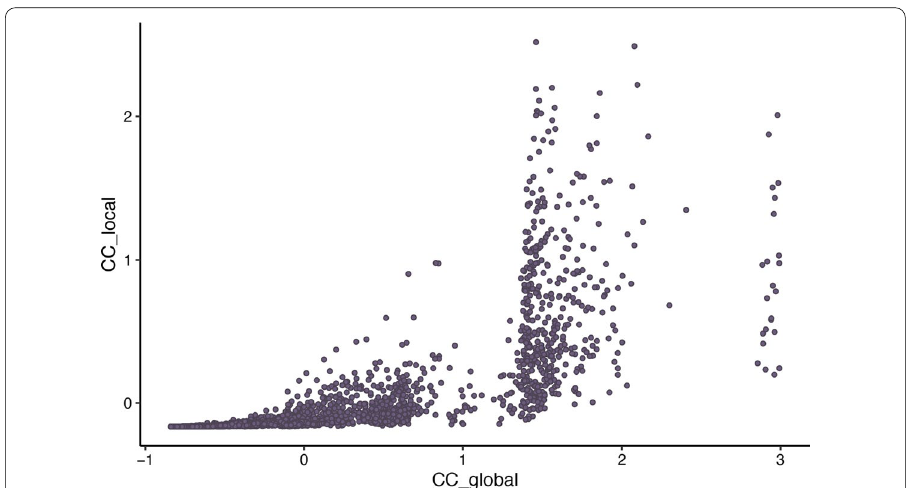
Fig. 5 Scatterplot of the z-standardised values of the local and global community centrality for each node. Values deviating > 3 SDs from the mean were excluded from